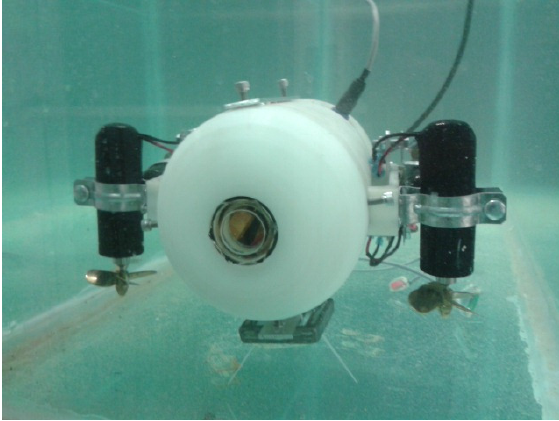
Figure 1. Experimental prototype